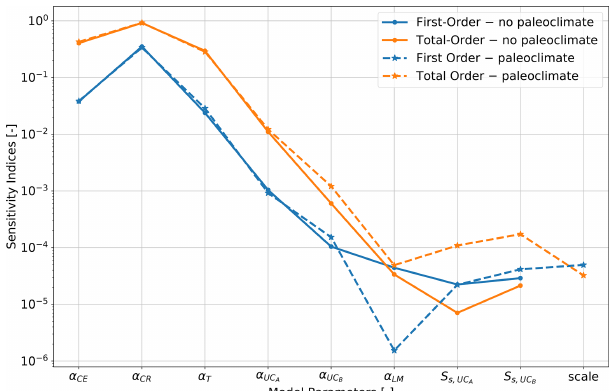
Figure 11. Global sensitivity indices for the analysis including pa- leotemperature information for the upper boundary condition. The first-order indices are denoted in blue and the total-order indices in orange. For the acronyms, please refer to Table